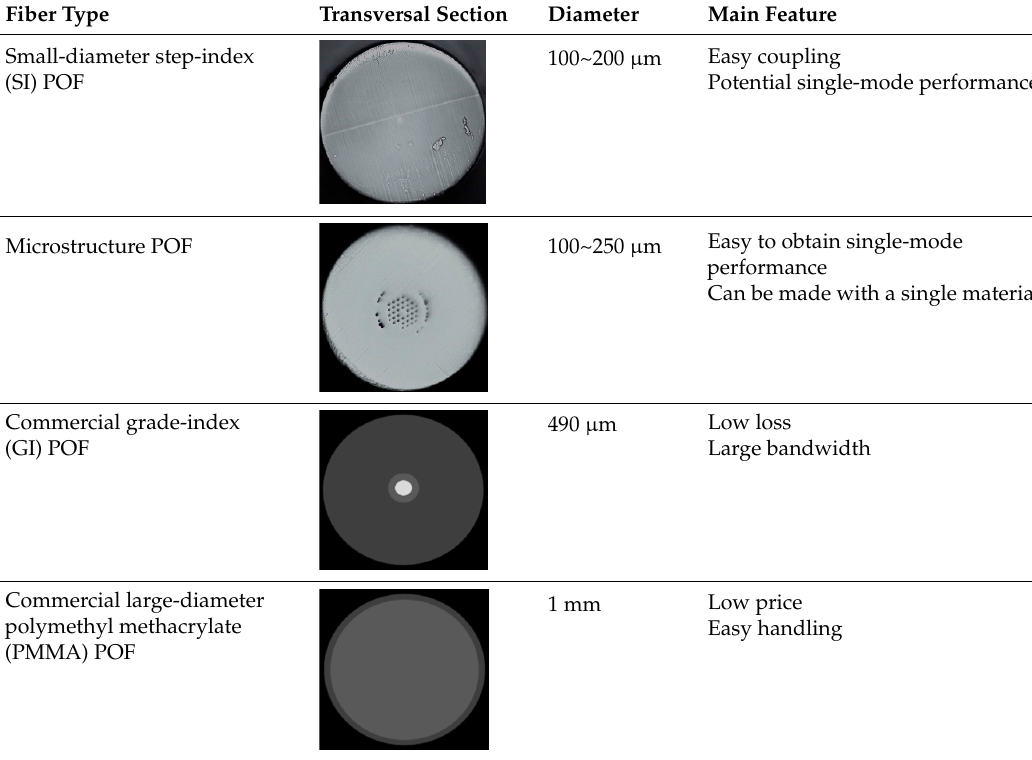
Table 1. Typical polymer optical fiber (POF) structures.